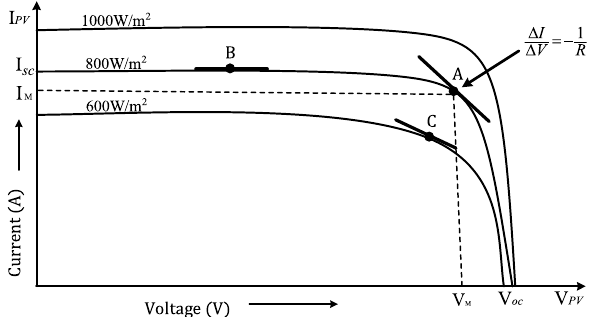
Figure 6. I-V characteristics of a solar panel with varying R 2 .